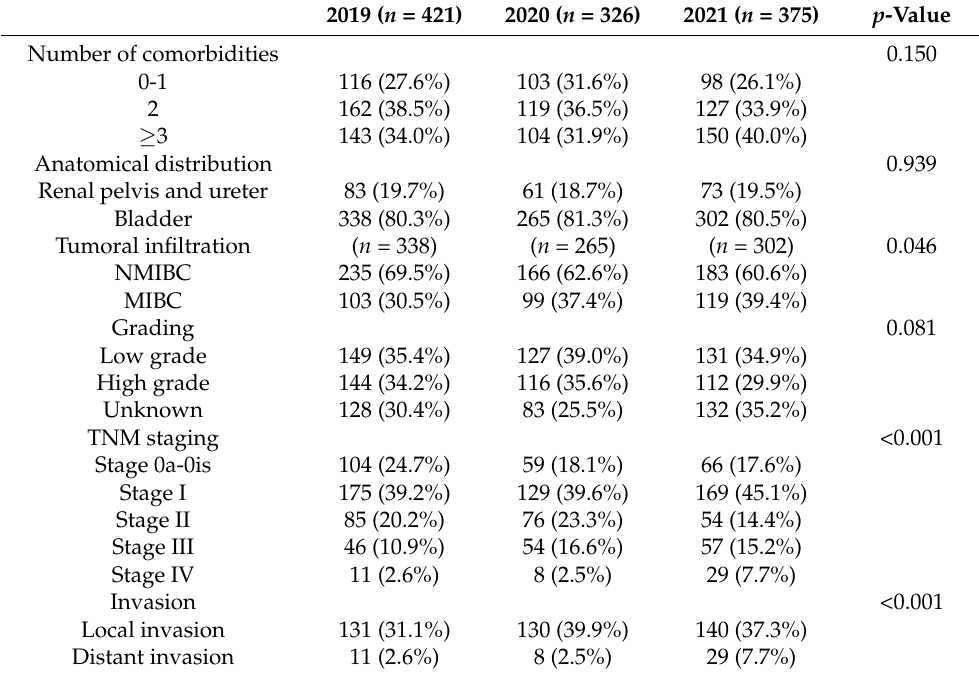
Table 2. Comparison of urothelial cancer characteristics during the study period.